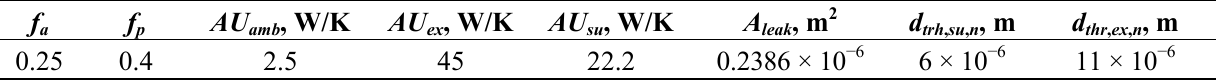
Table 1. Nominal parameters of the expander